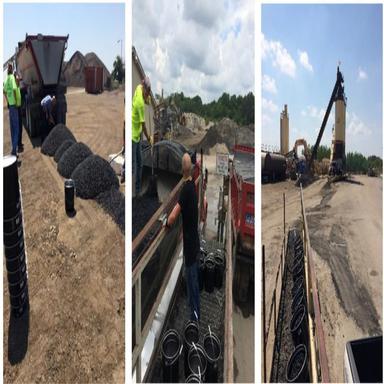
Sampling asphalt materials from different plants in Illinois.